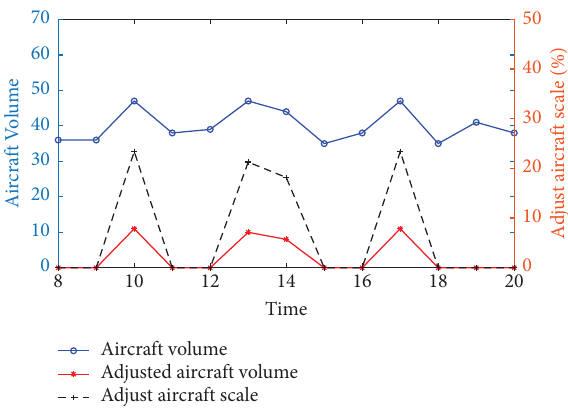
Figure 22: Te aircraft volume adjusted the number of aircraft and their proportions.